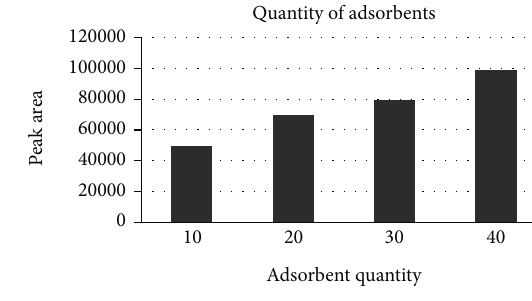
Figure 3: Graph of adsorbent ’ s quantity.